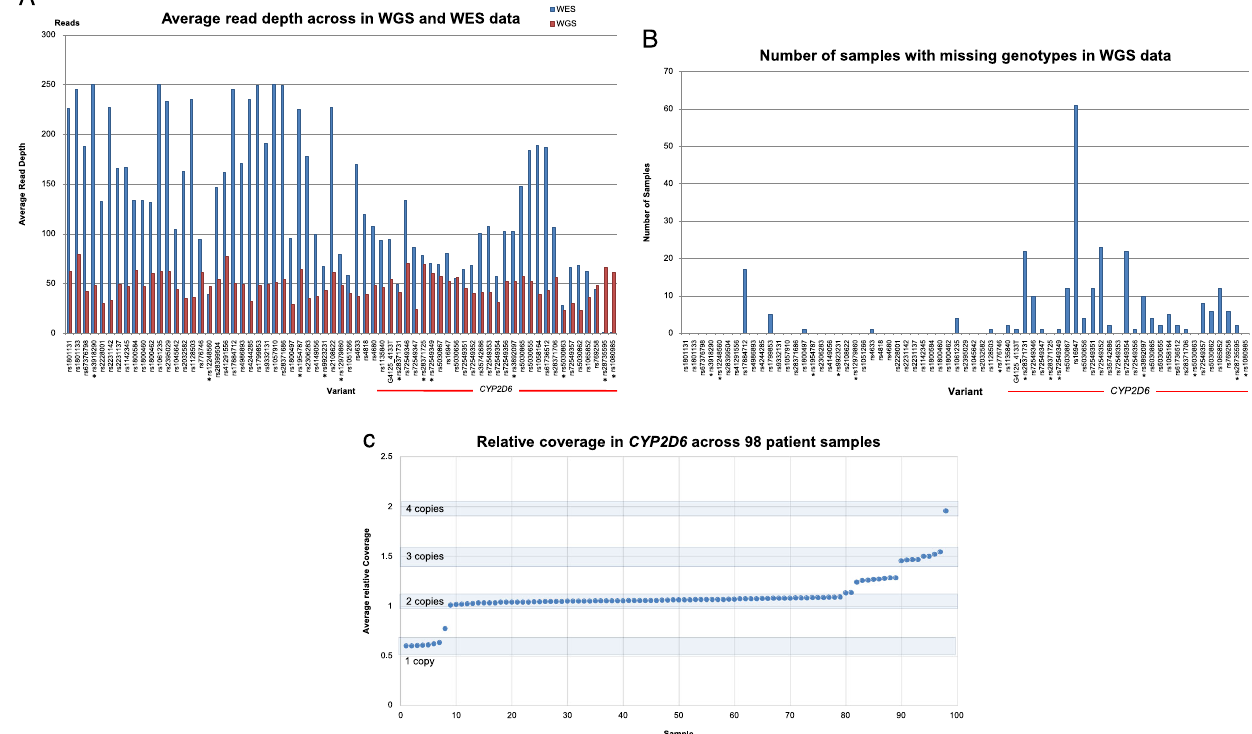
Fig. 1 a Average read depth across the 98 study samples in WGS (complete genomics) and WES (Illumina HiSeq) data. Project loci are displayed by Reference SNP and in order of genomic coordinate (within the gene), although not to scale. Variants denoted with an asterisk (*) are located in introns. b Number of samples with missing genotypes in WGS data found across the 98 study samples for each genomic coordinate. Variants denoted with an asterisk (*) are located in introns. c Relative coverage for a 6 kb window encompassing CYP2D6 gene across 98 patient samples. An average relative coverage of 1 in CYP2D6 is assigned a copy number of 2. The shared boxes (and number above them) denote the assigned CYP2D6 copy